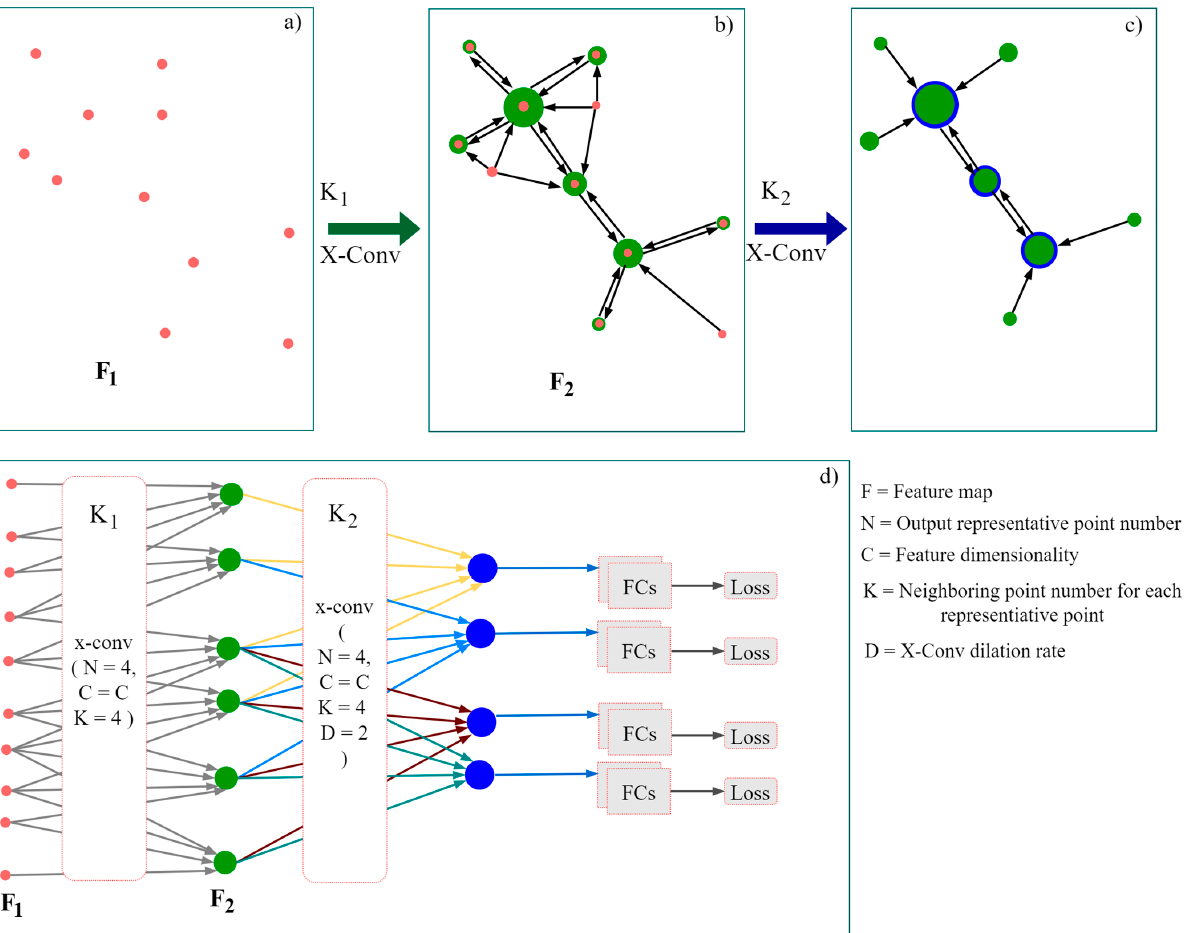
Figure 6. Principle functioning of PointCNN model: ( a ) Input dense point clouds, ( b , c ) diluted point clouds (green and blue dots) with fewer representations with multiple channels. ( d ) The overall Point CNN framework with two X ‐ Conv operators.